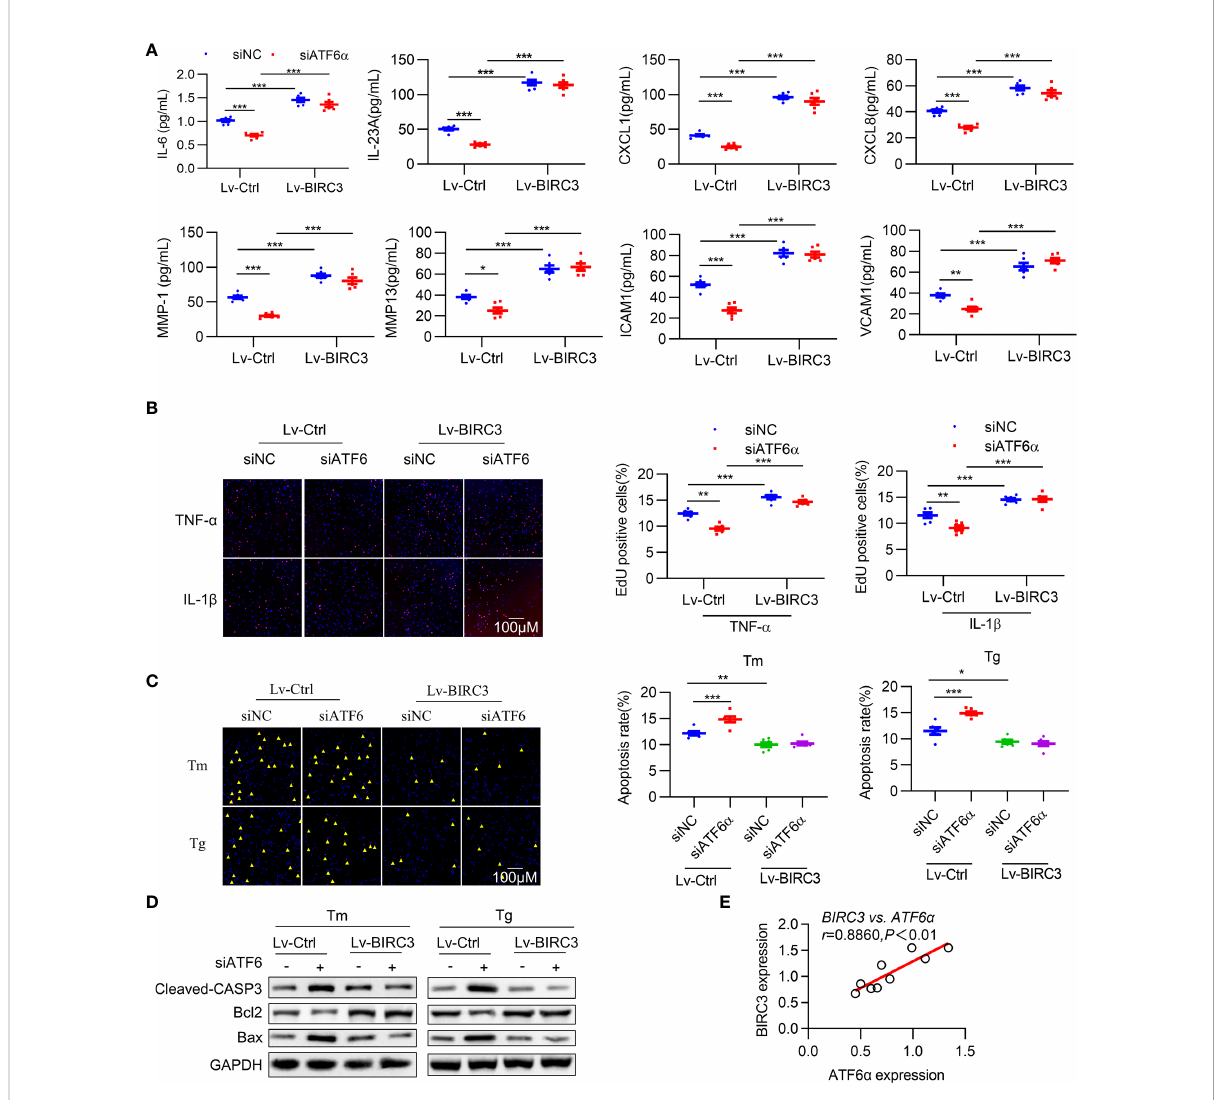
FIGURE 6 BIRC3 regulates in fl ammation and apoptosis of RA FLSs. RA FLSs were co-transfected with negative control siRNA (siNC) or ATF6 a siRNA (siATF6 a ) plus empty lentivirus (Lv-Ctrl) or BIRC3-overexpressing lentivirus (Lv-BIRC3) in the presence of Tm or Tg for 72 h. (A) , IL-6, IL-23A, ICAM1, VCAM1, CXCL1, CXCL8, MMP1 and MMP13 levels in cell culture supernatants were measured by ELISA. (B) , EdU assay was performed after overexpressing BIRC3 in ATF6 a -silenced RA FLSs for 72 h in the presence of TNF- a or IL-1 b (10 ng/mL). EdU incorporation was calculated as EdU + cells/total cells per fi eld, quanti fi ed by Image J. (C) , Apoptosis of RA FLSs was detected by TUNEL assay. The data are expressed as the percentage of TUNEL-positive cells per fi eld. (D) , Total protein was extracted for Western blot detection of Cleaved-CASP3, Bcl2, and Bax. (E) , Correlations of BIRC3 and ATF6 a expression. Pearson ’ s correlation coef fi cient (r) and P value are shown. Data are mean ± SD( n =6) and analyzed using one-way ANOVA (A – C) or Pearson correlation analysis (E) . n represent biologically independent samples (A) or fi elds of view (B, C) . * P < 0.05, ** P < 0.01, *** P < 0.001. Tm. tunicamycin; Tg, thapsigargin. The yellow triangle symbol marks TUNEL-positive